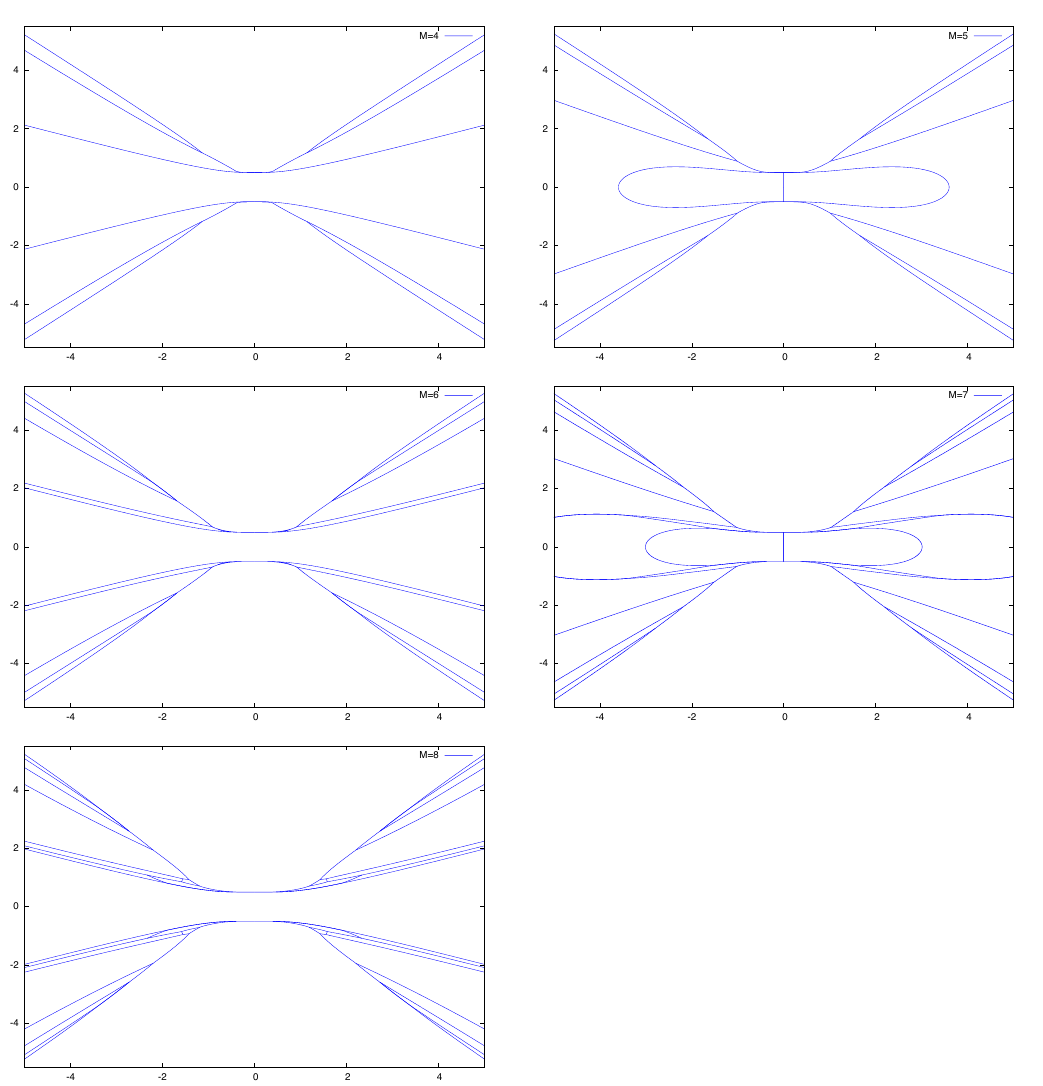
Figure 5 . Limiting curves of accumulation points of partition function zeros in the complex z -plane, shown in reading direction for M = 4 ; 5 ; (cid:1) (cid:1) (cid:1) ; 8.